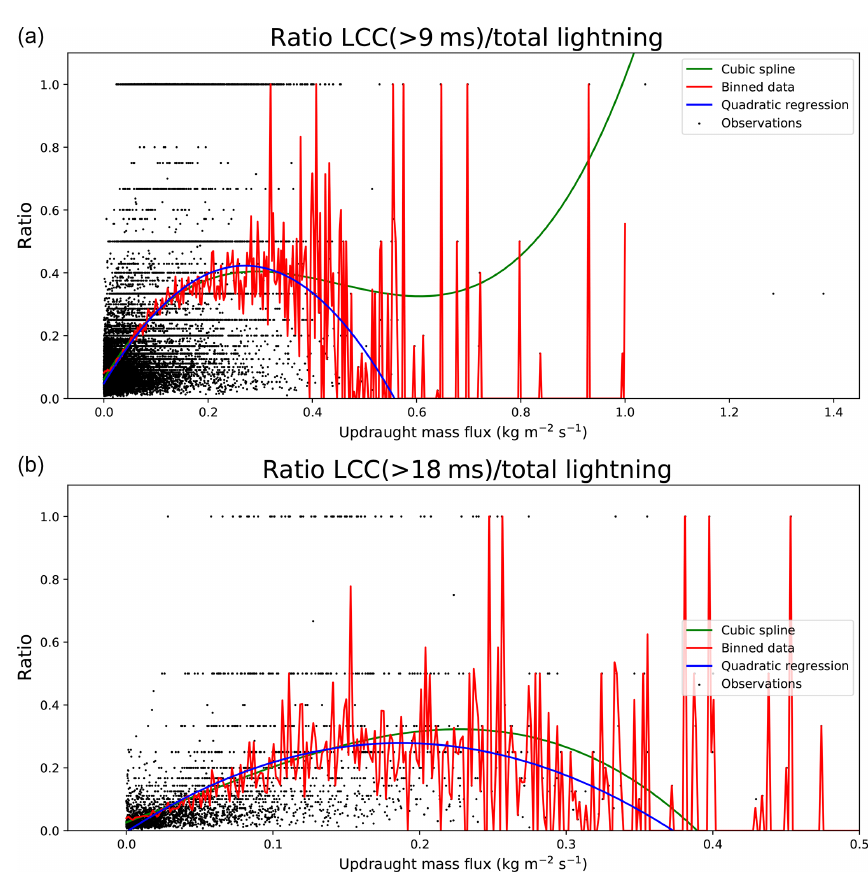
Figure 3. Ratios of (a) LCC( > 9ms) and (b) LCC( > 18ms) lightning to total lightning flashes versus the updraft mass flux as in Fig. 2. We have added a cubic smoothing spline (green line), a quadratic fitting (blue line), and a binning (red line) to the data as described in the